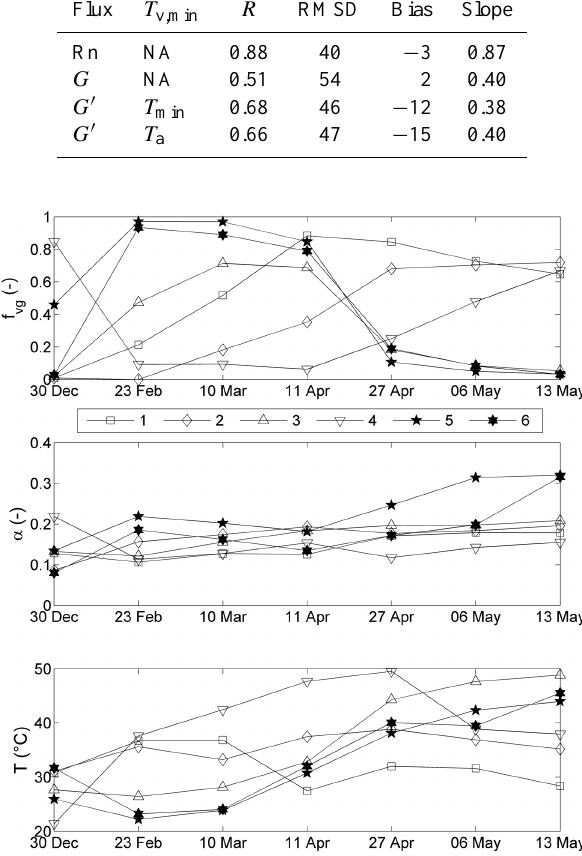
Fig. 5. Time series (arbitrary timescale) of f vg , α and T at each flux station